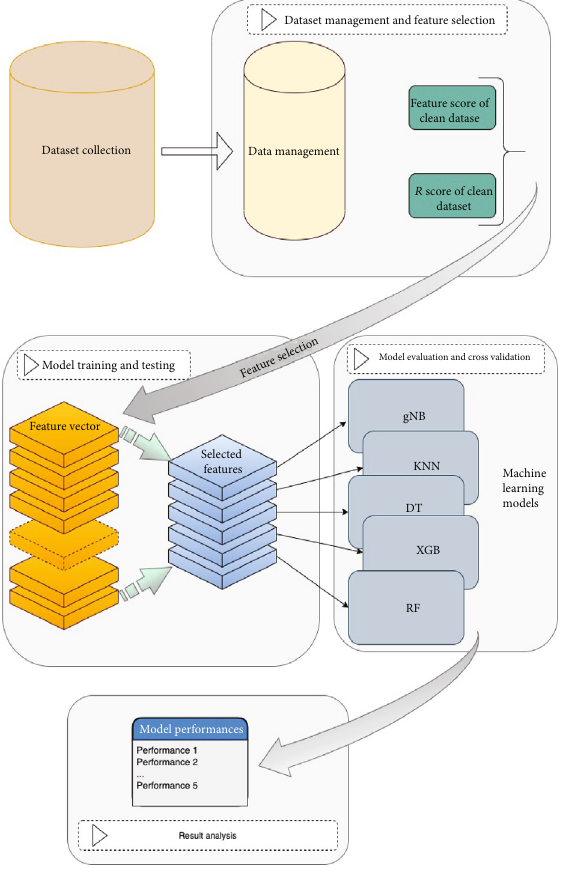
Figure 1: Steps of the data analysis. The study was organized into 5 stages: (1) Dataset collection. (2) Dataset managing and Feature Selection: the feature score (ANOVA) and r score (Pearson coe ffi cient correlation) were calculated between: (1) serum and CSF of MS vs. non-MS; (2) serum vs. CSF of MS and non-MS. (3) Model Training and Testing: the cytokines (features) having high feature score and r score > 0 : 5 were selected for developing machine learning model. (4) Model evaluation and Cross Validation: the data of the selected features was then given as input into the fi ve (gNB, KNN, DT, XGB, and RF) machine learning models to predict the outcome of the disease. (5) Results analysis: the performance of each model was evaluated by calculating